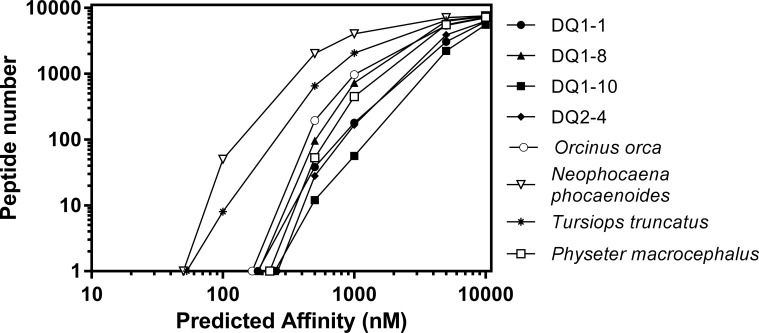
Predicted binding affinities of peptide sequences derived from proteins encoded by cetacean MHC II DQ alleles.Binding affinities of 7,634 peptide sequences predicted by NNAlign were compared by counting the number of peptides below 100, 500, 1000, 5000 and 10,000nM thresholds. The algorithm was supplied with a 7,647 amino acid sequence and the DQA and B protein sequences from cetaceans (killer whale, sperm whale, finless dolphin) obtained from Genbank and from bottlenose dolphins in the Indian River Lagoon (IRL) and adjacent Atlantic coast (ATL) (DQ1-1; Protein derived from DQA 1*01 DQB 1*01 DQ1-8; Protein derived from DQA 1*01 DQB 1*08 DQ1-10; Protein derived from DQA 1*01 DQB 1*10 and DQ2-4; Protein derived from DQA 1*02 DQB 1*04).